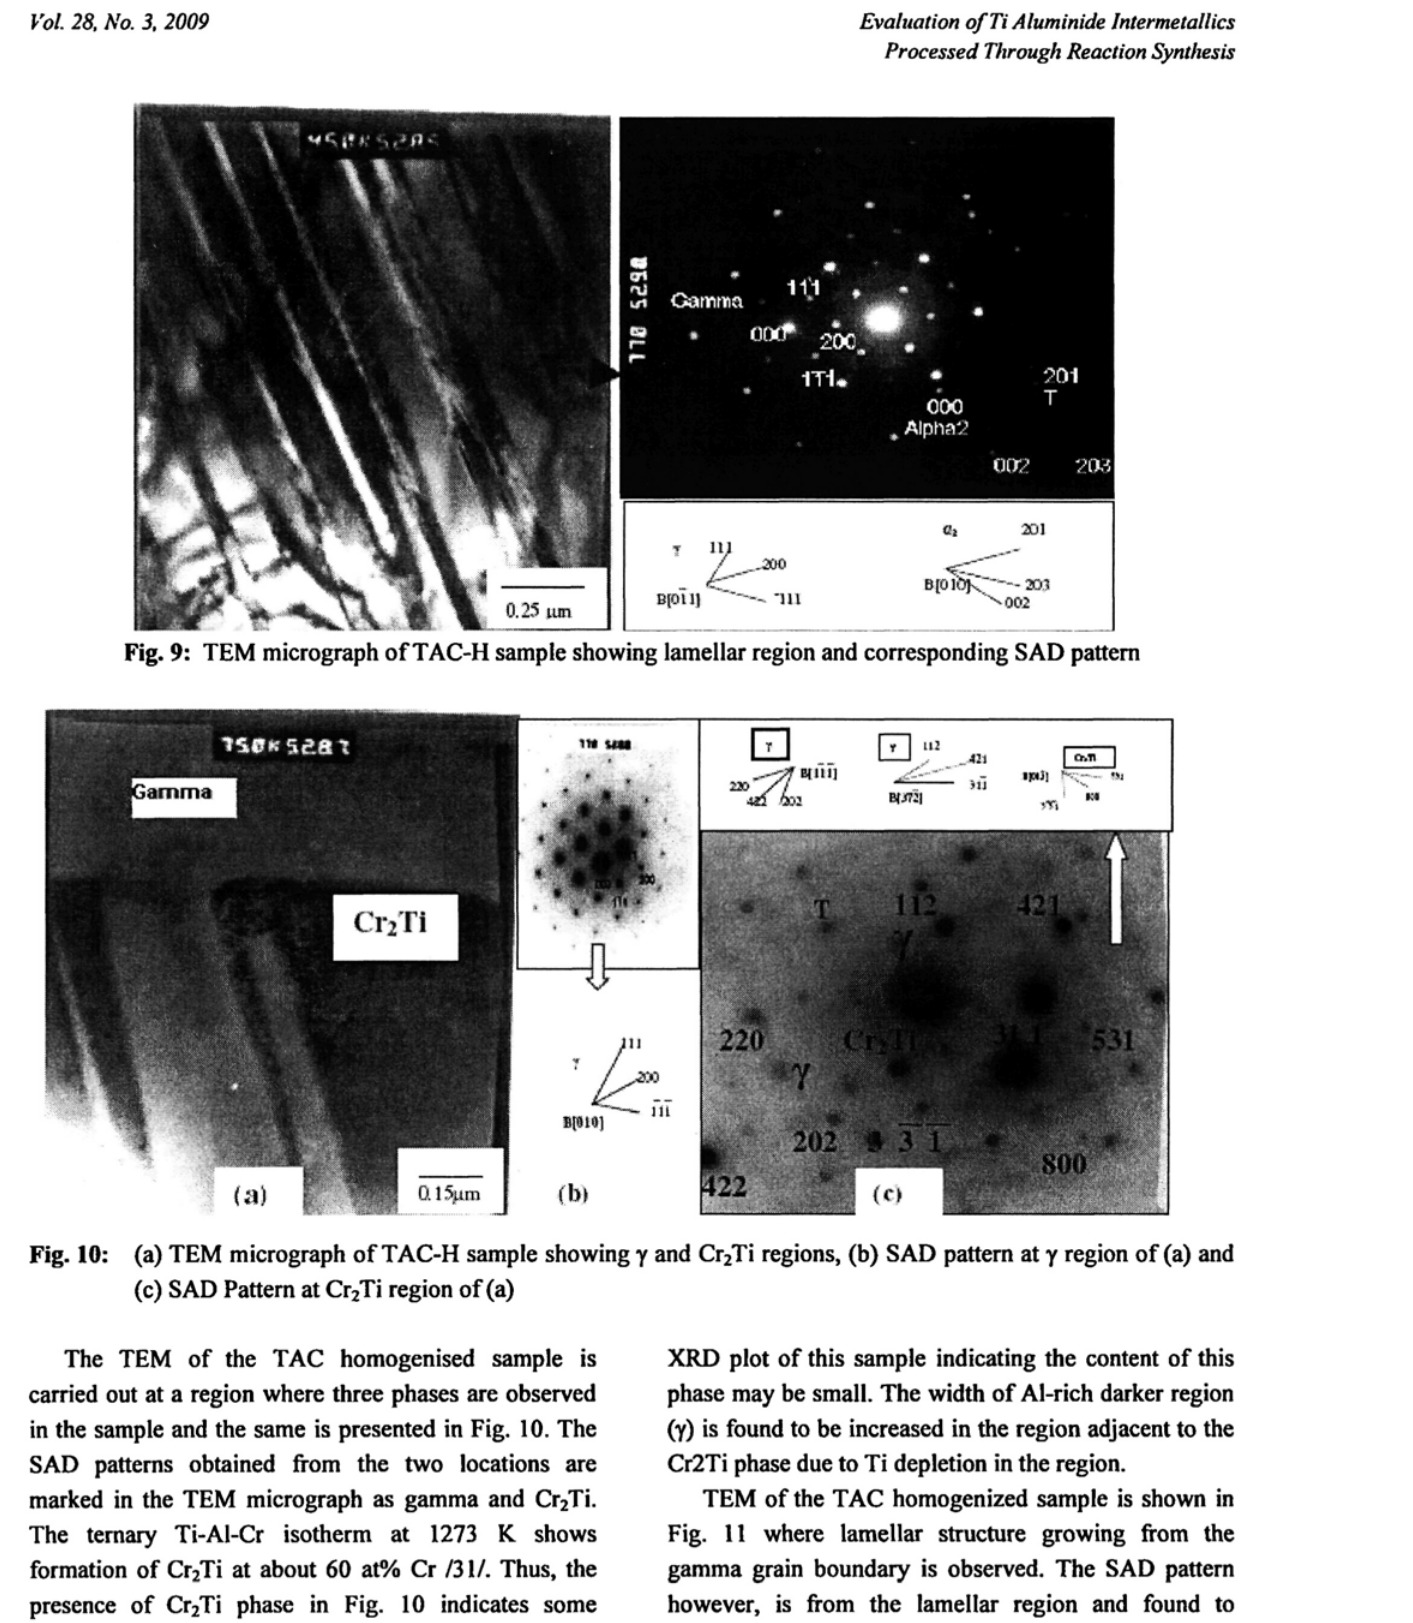
(a) Fig. 10: (a) TEM micrograph of TAC-H sample showing γ and Cr (c) SAD Pattern at Cr Ti region of 2